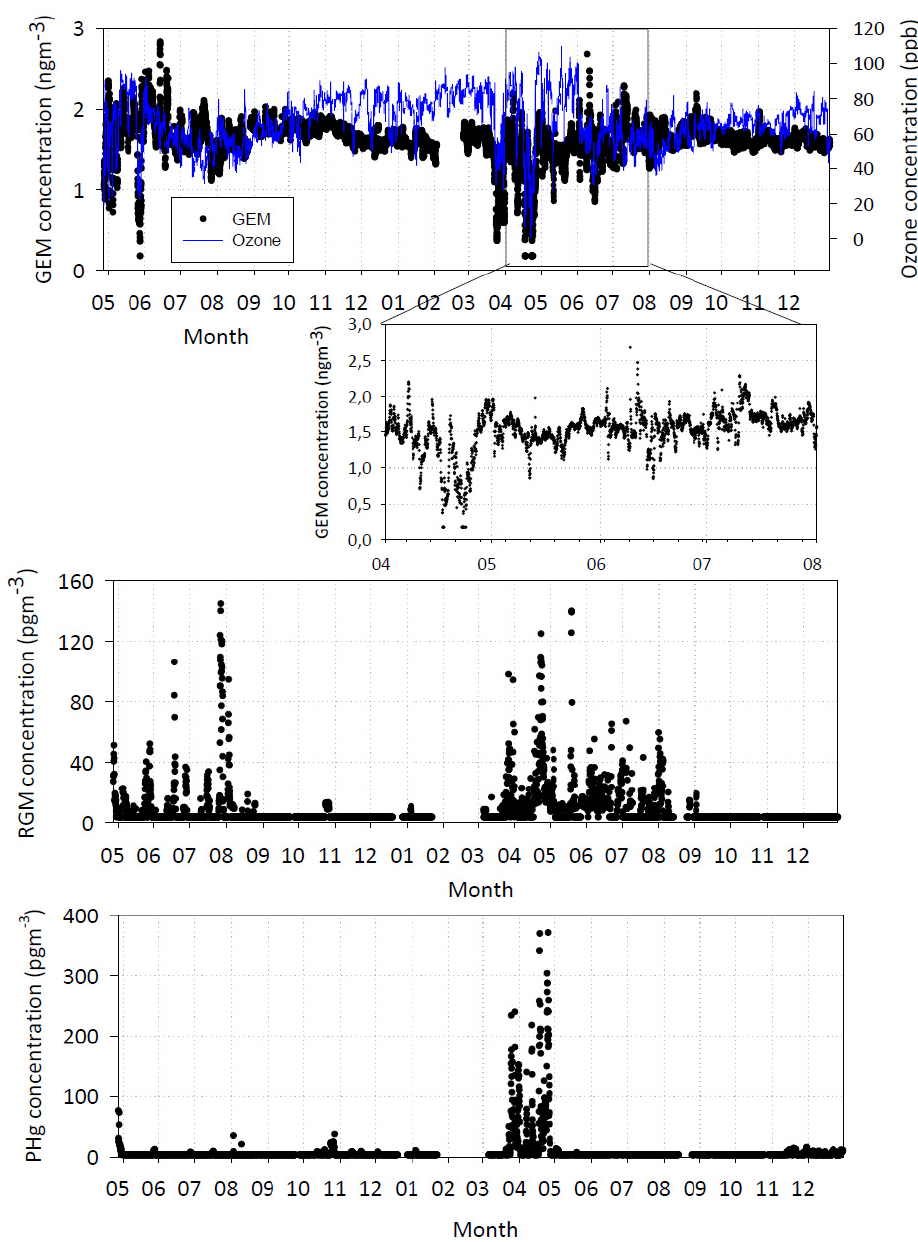
Fig. 2. Hourly average GEM concentrations, hourly average ozone concentrations and two hour average concentrations of RGM and PHg. The x label refers to the months from the initiation of the measurements in April